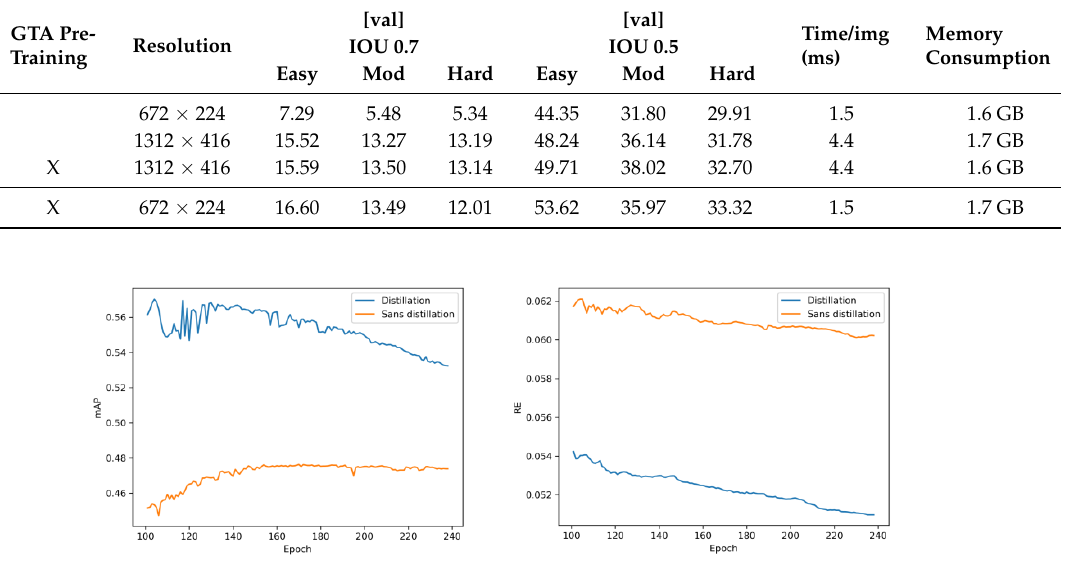
Figure 6. Comparison of the training on KITTI between a distilled and a classic model.